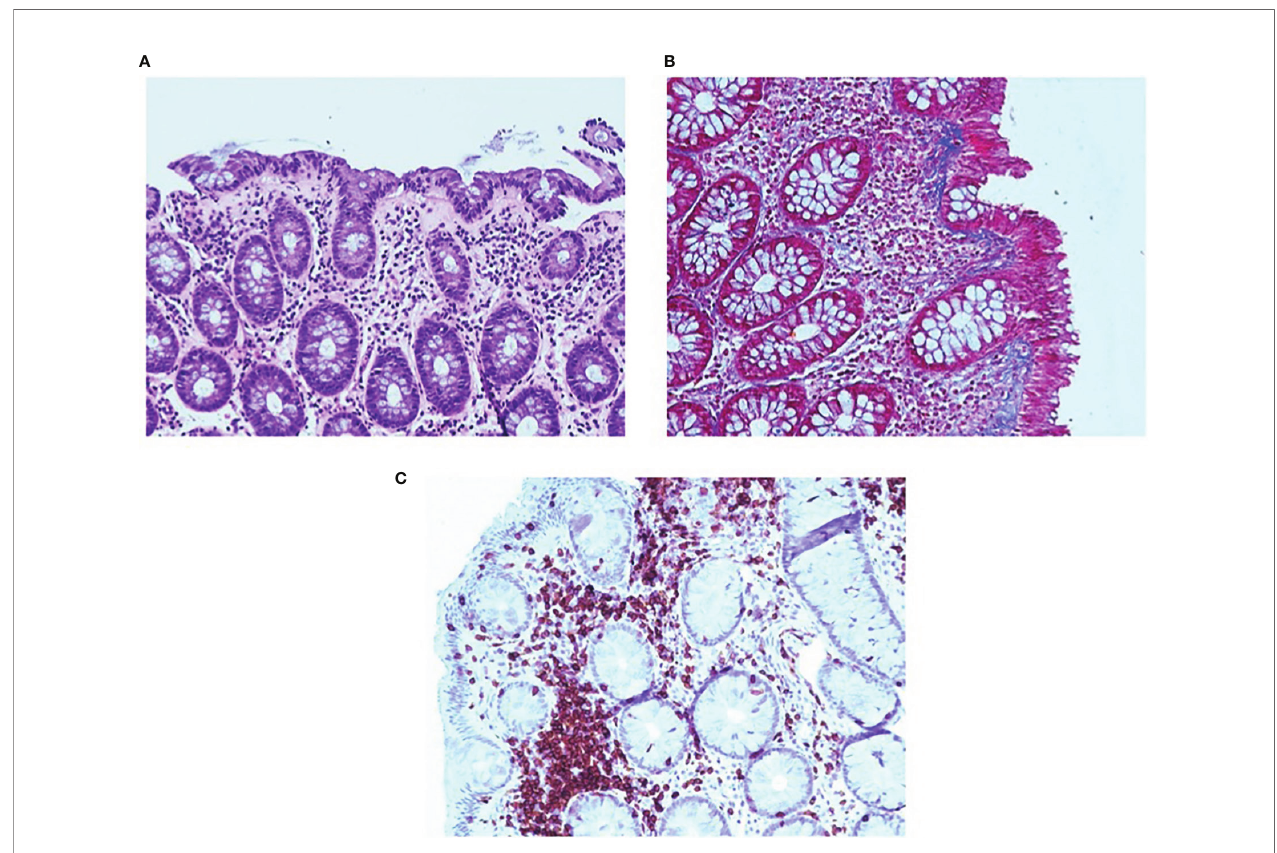
FIGURE 2 | Collagenous colitis pattern. The pink band is seen beneath the surface epithelium and the lamina propria contains increased chronic in fl ammation (A) . Masson trichrome stain highlights the irregularly expanded subepithelial collagen thickening. Note the entrapped in fl ammatory cells and small vessels (B) . CD3 immunostain. The CD3 immunostain con fi rms that the lymphocytes CD3+ T-cells are predominantly in the lamina propria and are increased (C)